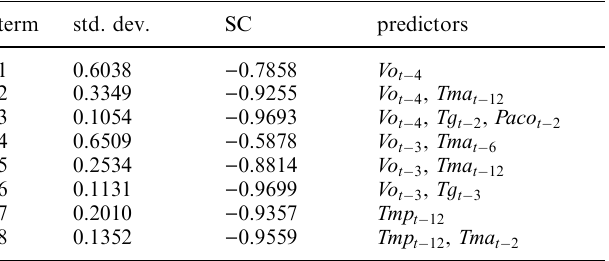
Table 2. Relative importance of terms